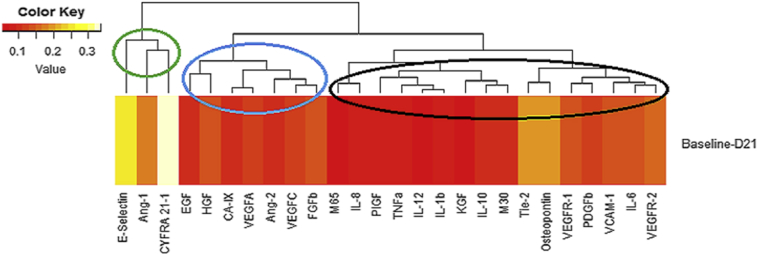
Heat Map (With Clustergram) of the Kolmogorov–Smirnov Test Statistic Matrix Comparing Each Day-21 (D21) Value With BaselineAbbreviations: Ang = angioprotein; CA-IX = carbonic anhydrase; CYFRA 21-1 = cytokeratin-19 antigen; EGF = epidermal growth factor; FGFb = basic fibroblast growth factor; HGF = hepatocyte growth factor; IL = interleukin; KGF = keratinocyte growth factor; M30 = cytokeratin 18 cleaved; M65 = cytokeratin 18 intact; PDGFb = platelet-derived growth factor B ; PIGF = placenta growth factor; Tie-2 = tyrosine kinase 2; TNF = tumor necrosis factor; VCAM = vascular cell adhesion molecule; VEGF = vascular endothelial growth factor; VEGFR = vascular endothelial growth factor receptor.